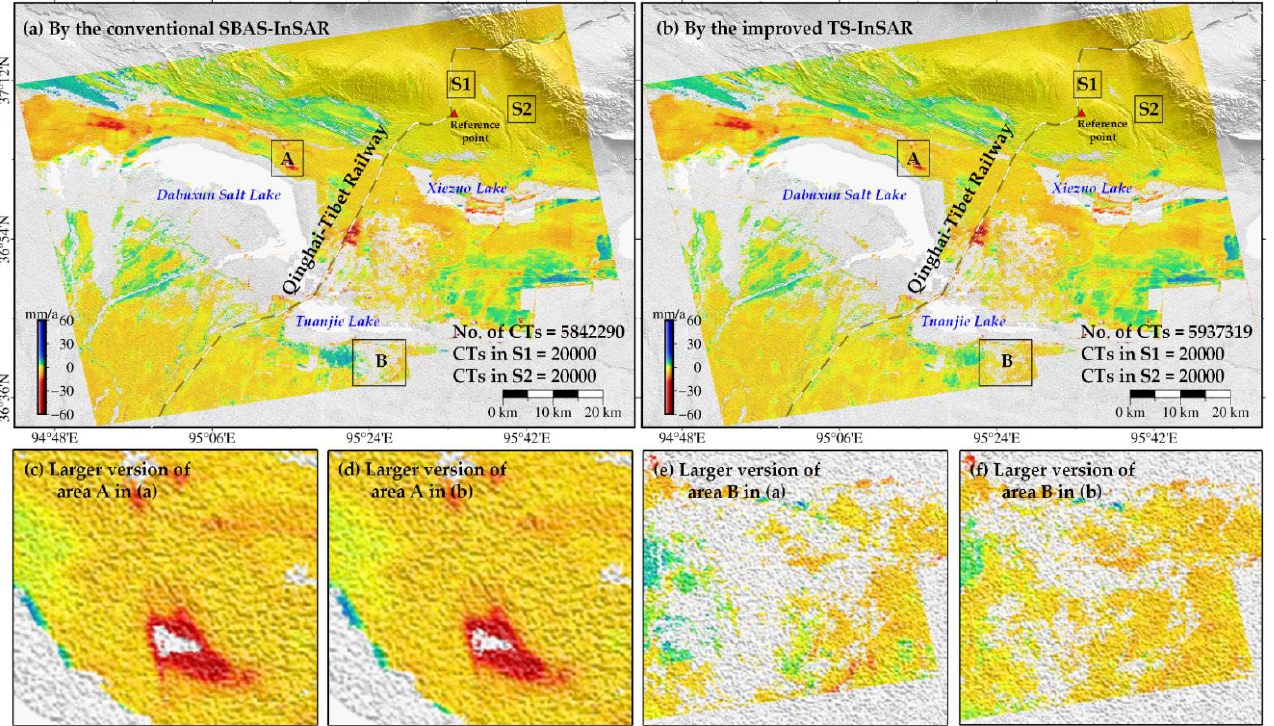
Figure 8. The upper left subplot ( a ) is the deformation velocity map derived by the conventional SBAS-InSAR with the temporal baseline of 49 days, and the upper right subplot ( b ) is the deformation velocity map derived by the improved TS-InSAR with the temporal baseline of 49 days, ASC of interferograms higher than 0.5.